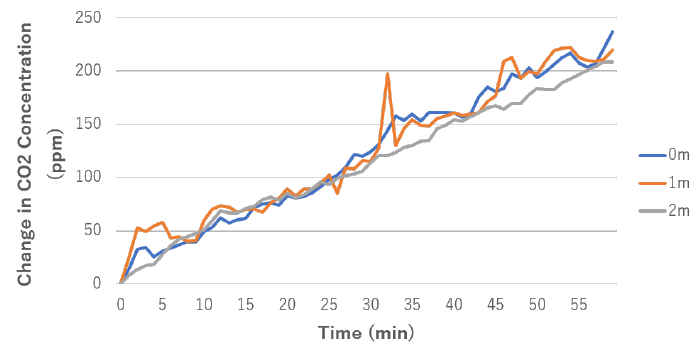
Figure 7. Change in CO 2 concentration at 1 m away from subjects, in Case 2.